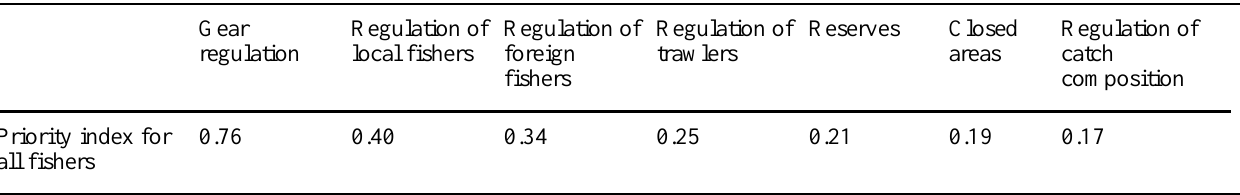
Table 3. Priority ranking of preferred management options as perceived by fishers in Mombasa ( n =70) and Diani–Chale ( n